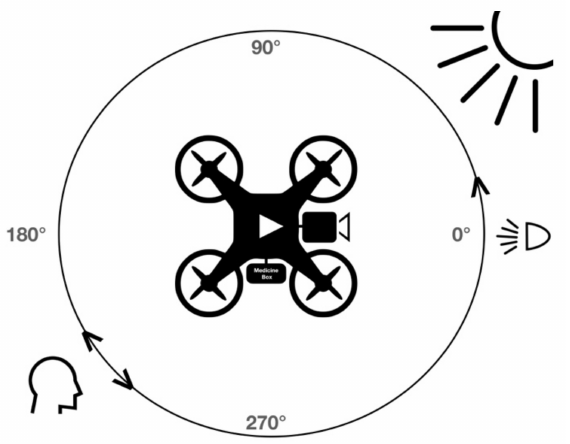
Figure 3. Drone rotates (yaw) 360 ◦ around vertical axis at the same